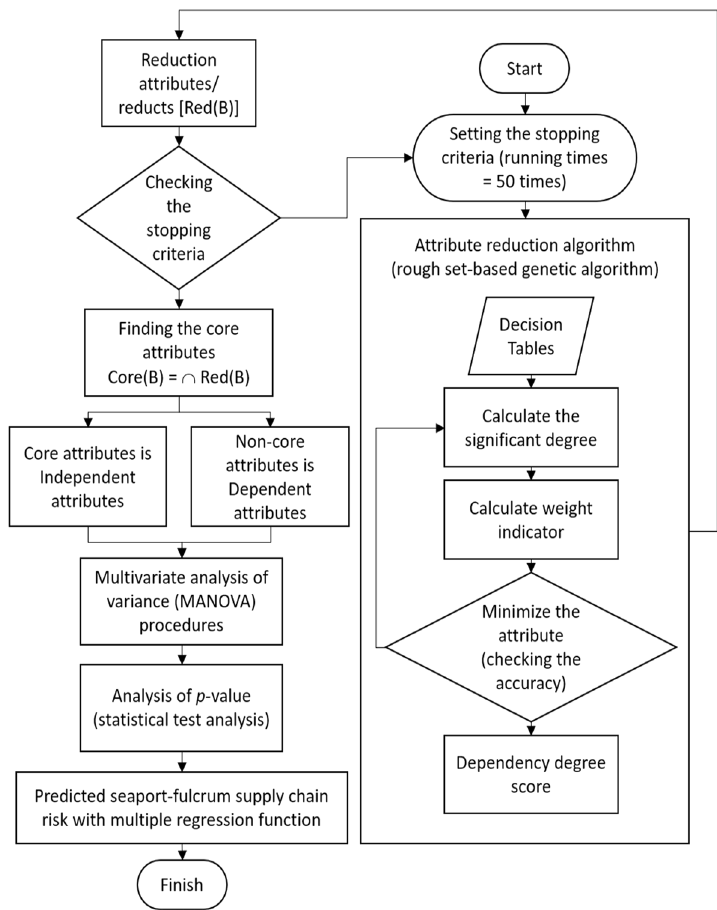
Fig. 2 Flowchart of the